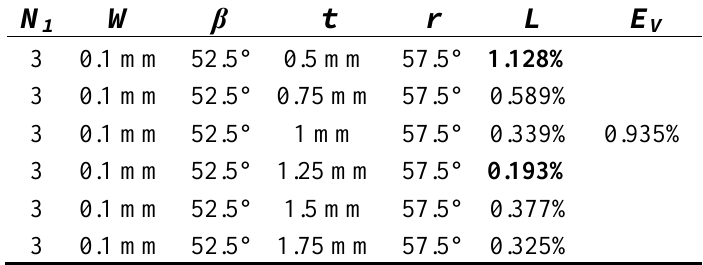
Table 7. Nonlinearity errors of the sensors with different rotor